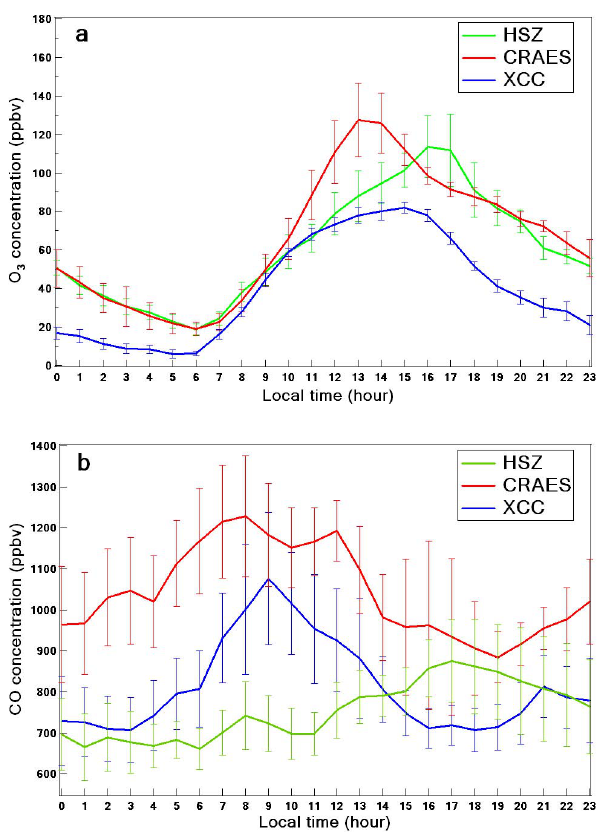
Fig. 7. Average diurnal variation of (a) ozone and (b) CO at three sites for eight ozone-pollution days when southerly winds prevailed. Vertical bars are half standard